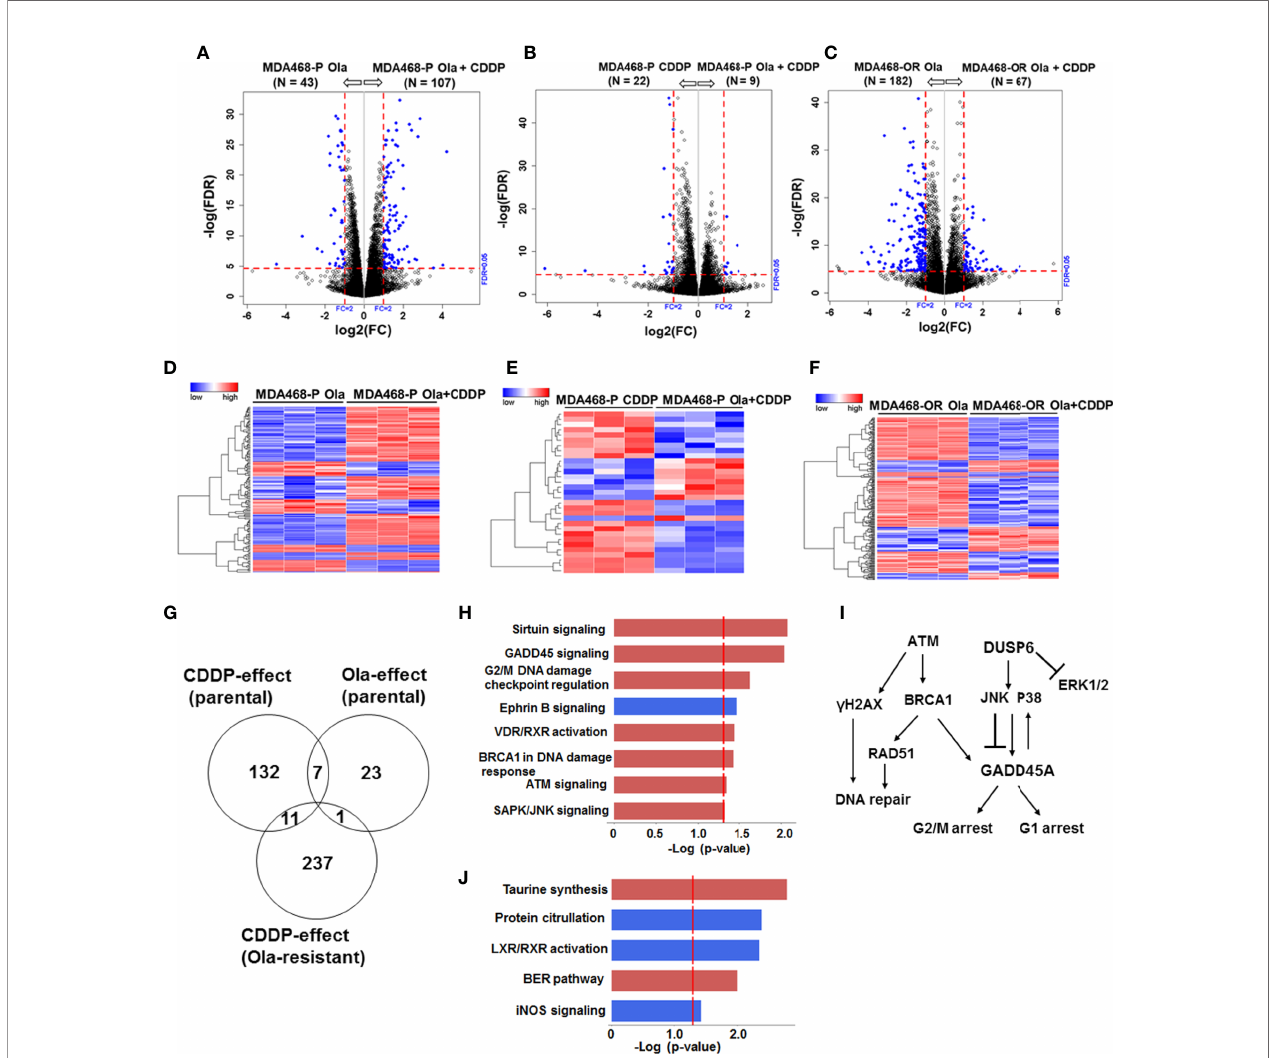
FIGURE 7 | Olaparib resistant (OlaR) and parental BRCA1 wild type MDA-MB-468 TNBC cells respond similarly to cisplatin (CDDP) with upregulation of DNA damage response pathways. RNA-seq analysis was performed on isogenic parental and OlaR MDA-MB-468 TNBC cells. Parental cells were treated with 3 m M olaparib, 2.5 m M CDDP or their combination. The corresponding OlaR MDA-MB-468 cells represent cells maintained in 15 m M olaparib without interruption and were used as such or treated with 2.5 m M CDDP. (A – C) Volcano plots. Each point in the volcano plot represents one gene. The blue and black dots represent differentially expression genes (DEGs) and unchanged genes, respectively. The horizontal and vertical dotted red lines indicate 5% FDR and fold-change (FC) of ≥ 2, respectively. The numbers (N) in parentheses at the top are the total number of DEGs that have larger expression levels in the corresponding group. (D – F) Hierarchical cluster maps; (G) Venn diagram of DEGs, 5% FDR and FC ≥ 2) and overlap in olaparib- and CDDP-induced genes in parental and OlaR counterparts. (H) CDDP impacted canonical pathways (red, upregulation and blue, downregulation) identi fi ed by IPA of 11 DEGs in the Venn diagram and (I) schematic representation of the affected pathways. (J) Olaparib impacted pathways identi fi ed by IPA corresponding to 23 DEGs in the Venn